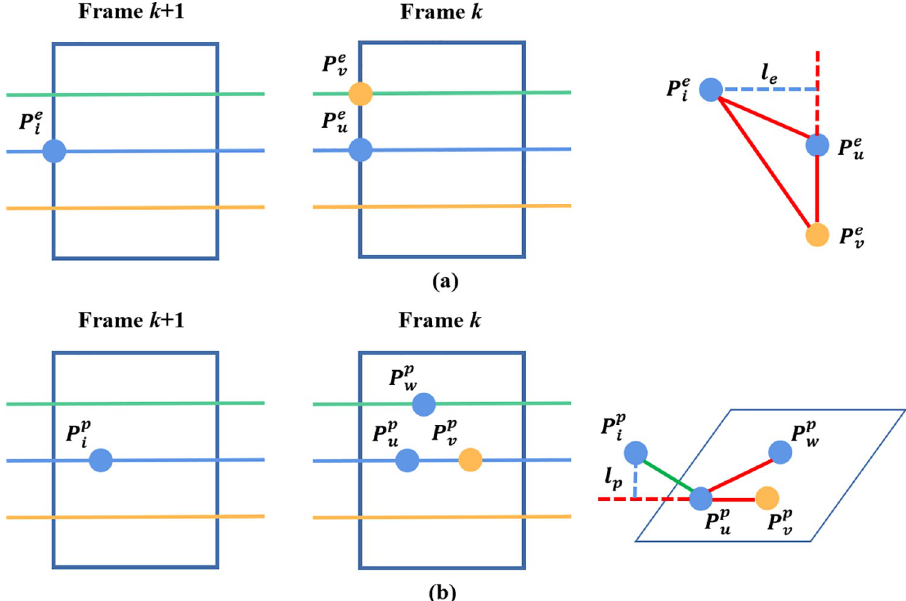
Fig 4. Comparison of feature points and constraint relationships between frames: (a) edge feature points and loss l e , (b) planar feature points and loss l p . Different color points represent different semantic labels.